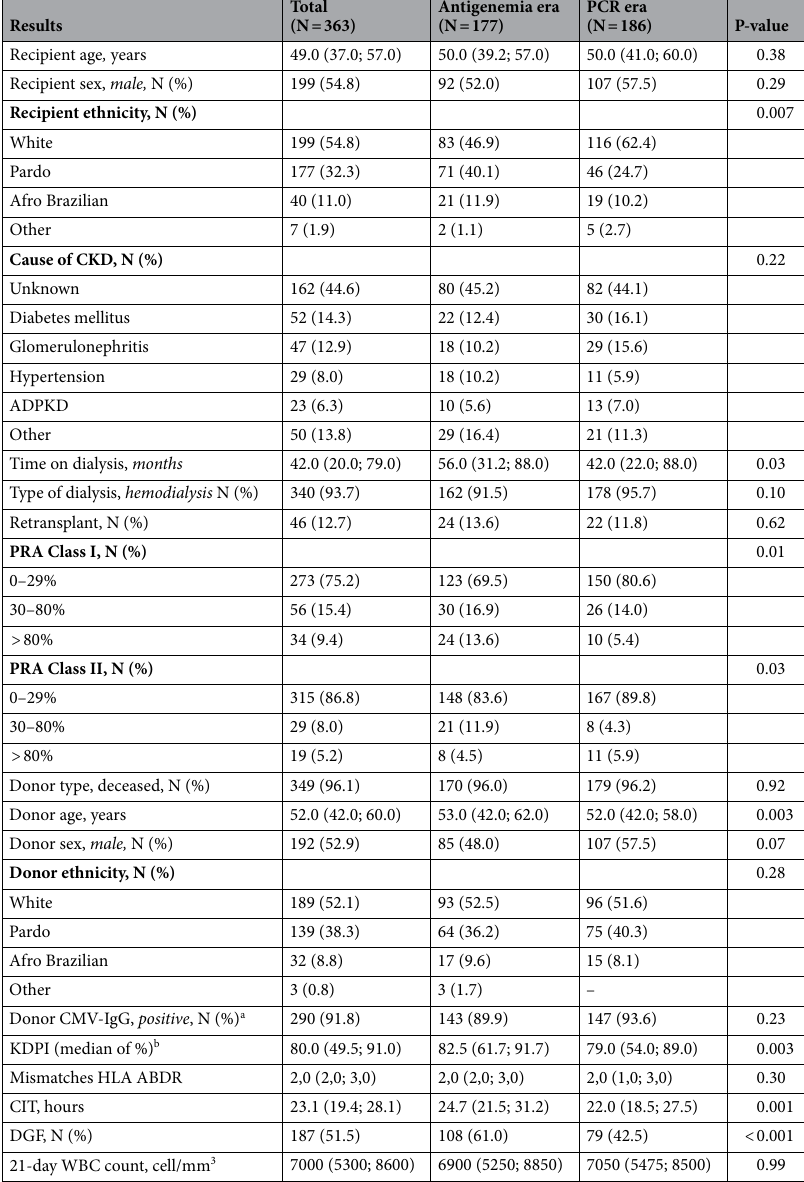
Table 1. Demographic data according to the era: antigenemia and PCR. ADPKD, autosomal dominant polycystic kidney disease; CIT, cold ischemia time; CKD, chronic kidney disease; DGF, delayed graft